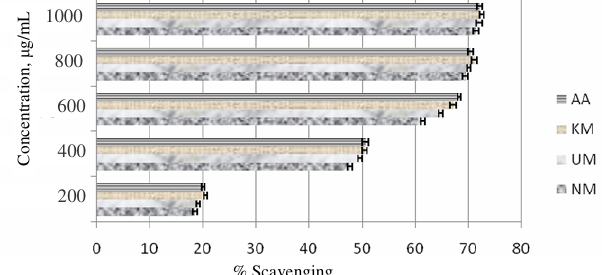
Figure 1. Free radical scavenging activity of various amounts of ethanol extracts of NM, UM and KM (Values are mean ± SD of five determinations; AA=Ascorbic acid)